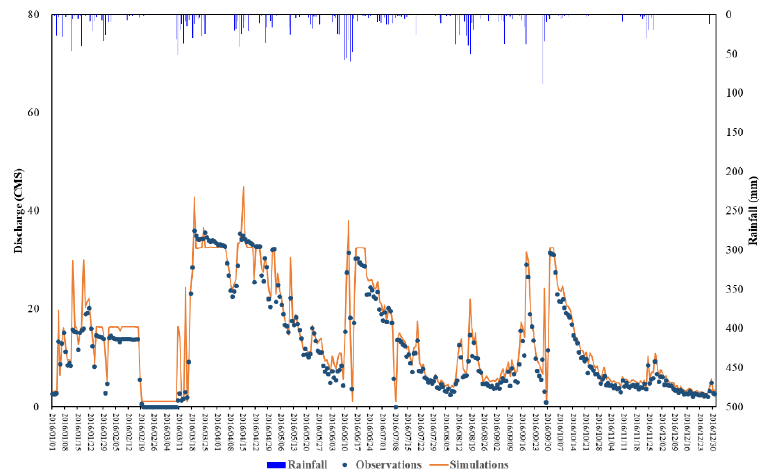
Figure 5. The model calibration (2015 data) and verification (2016 data) of the flow simulations of the SWMM.